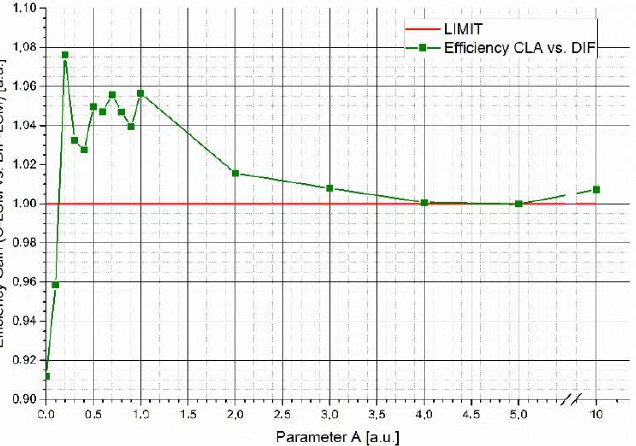
Figure 2. Efficiency gain (P) of the C-LSM algorithm versus the W DIF -LSM algorithm. In the plot are reported the trend of the efficiency gain through the two algorithms as a function of the increase in the fundamental parameter A .